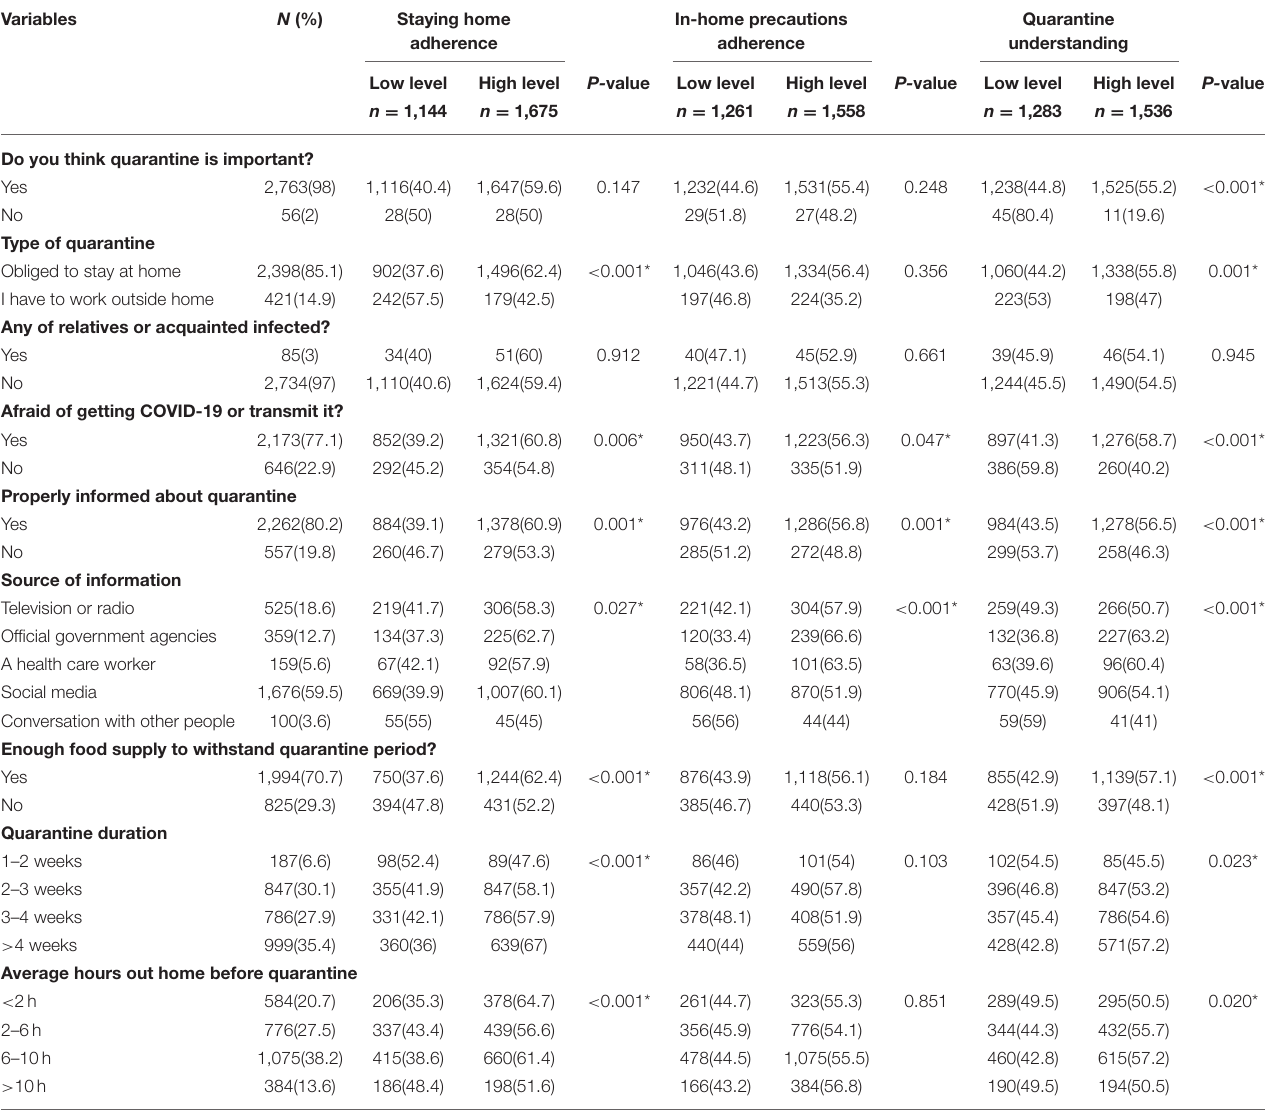
TABLE 2 | Bivariate analysis of quarantine characteristics with dependent variables (Staying home adherence; In-home precautions adherence; Quarantine understanding; P -value presented was Chi-square significance; N = 2,819). Variables Staying home In-home precautions adherence